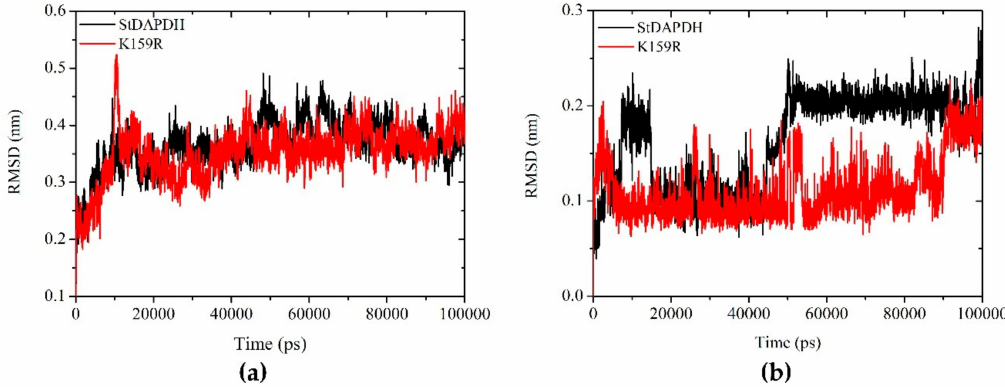
Figure 3. Root mean square deviation (RMSD) analysis of ( a ) proteins and ( b ) NADH of wild-type (black) and K159R (red) enzymes over a 100 ns simulation